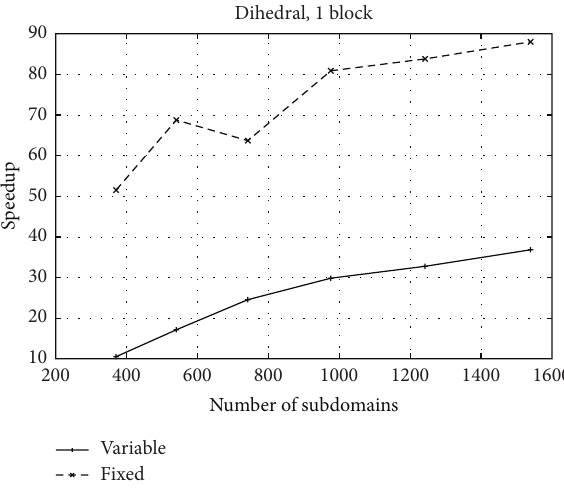
Figure 5: Monostatic RCS for the cobra cavity.